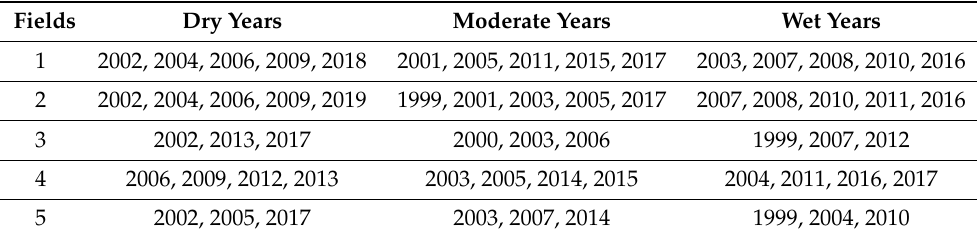
Table 2. In-crop rainfall (ICR) classification. Fields